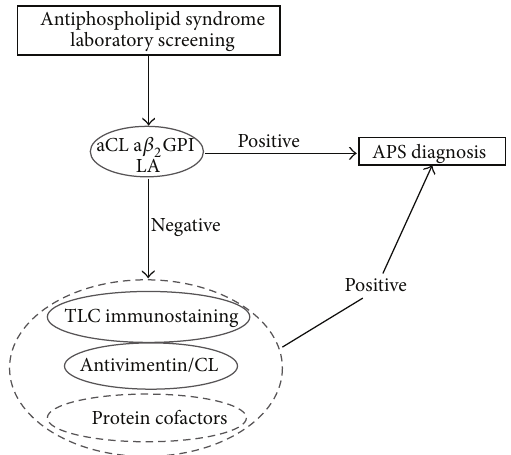
Figure 1: Proposed algorithm depicting the different diagnostic approaches in the most reliable sequence to reveal the hidden reactivity of the conventional aPL